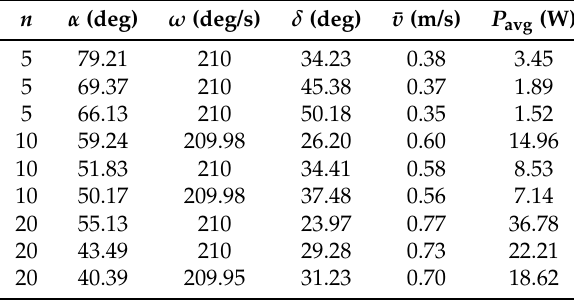
Table 6. Multi-objective optimization results for the eel-like motion pattern for the USR with different numbers of links, without considering the negative work